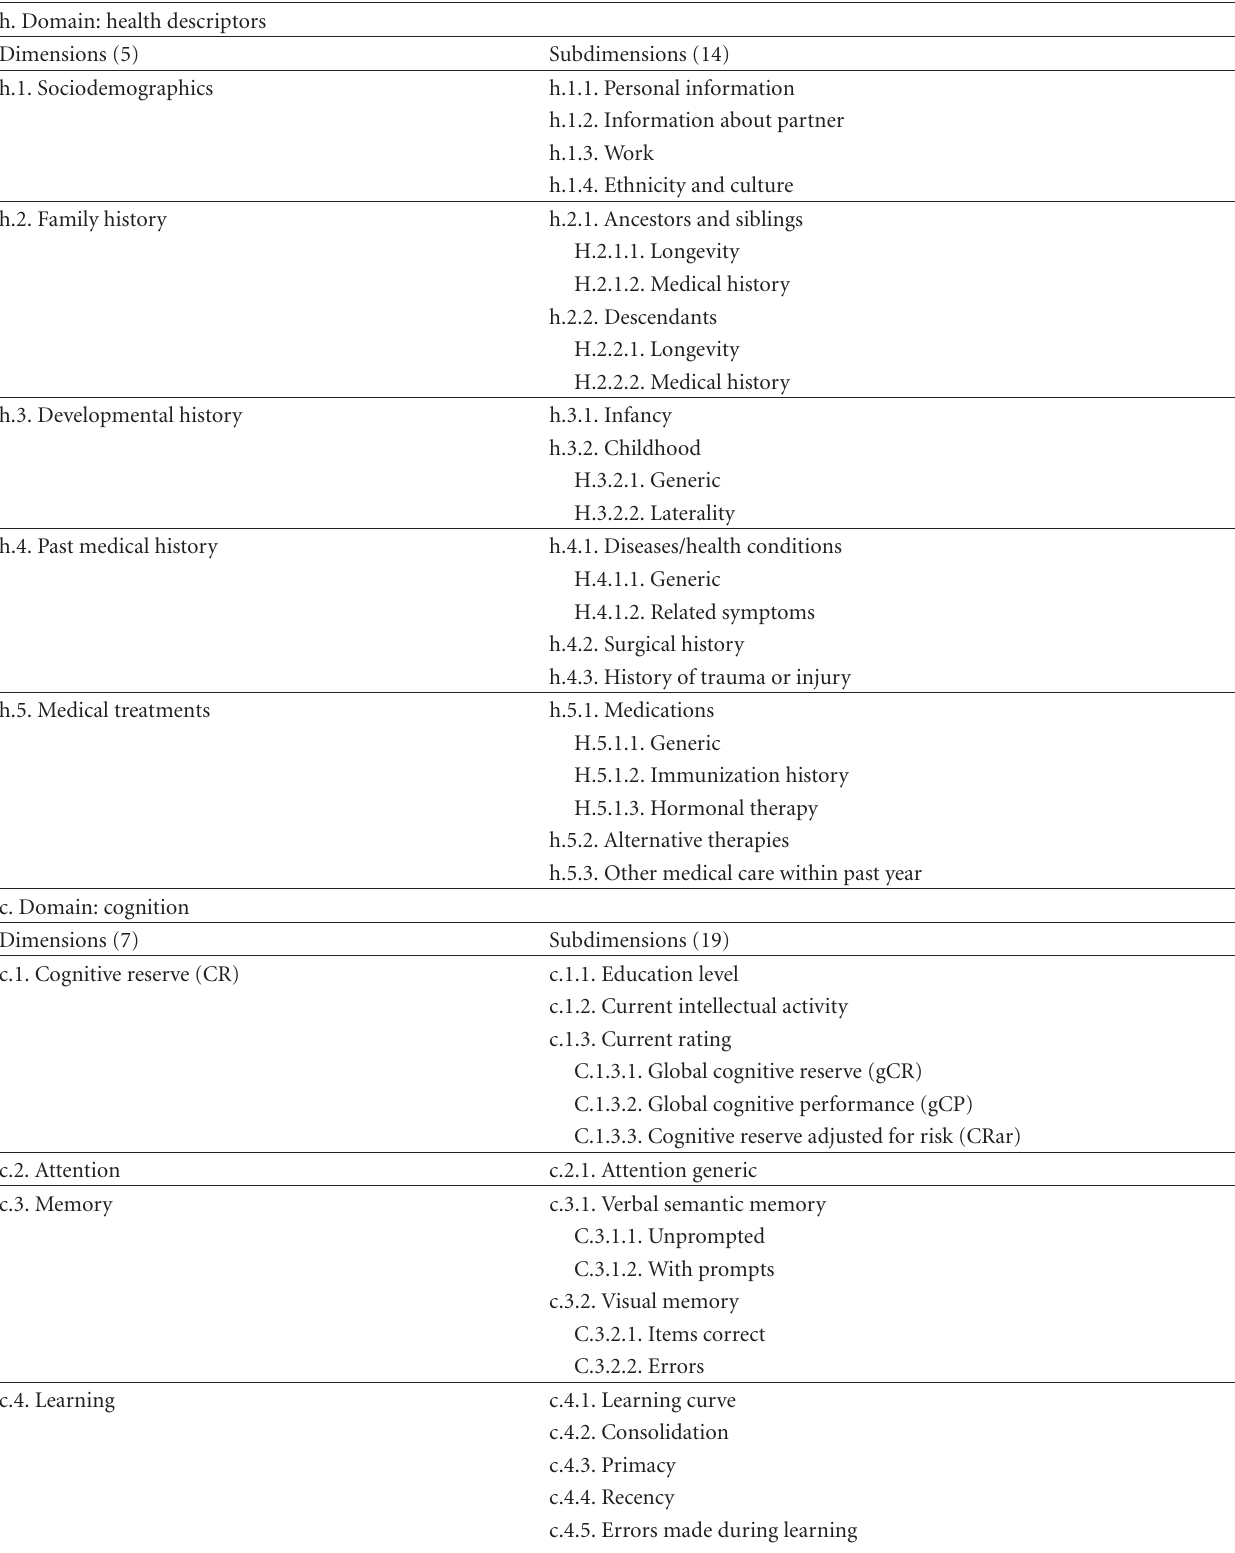
Table 3: Classification system of health-related behaviors (7 domains, 3 subdomains, 43 dimensions, and 141